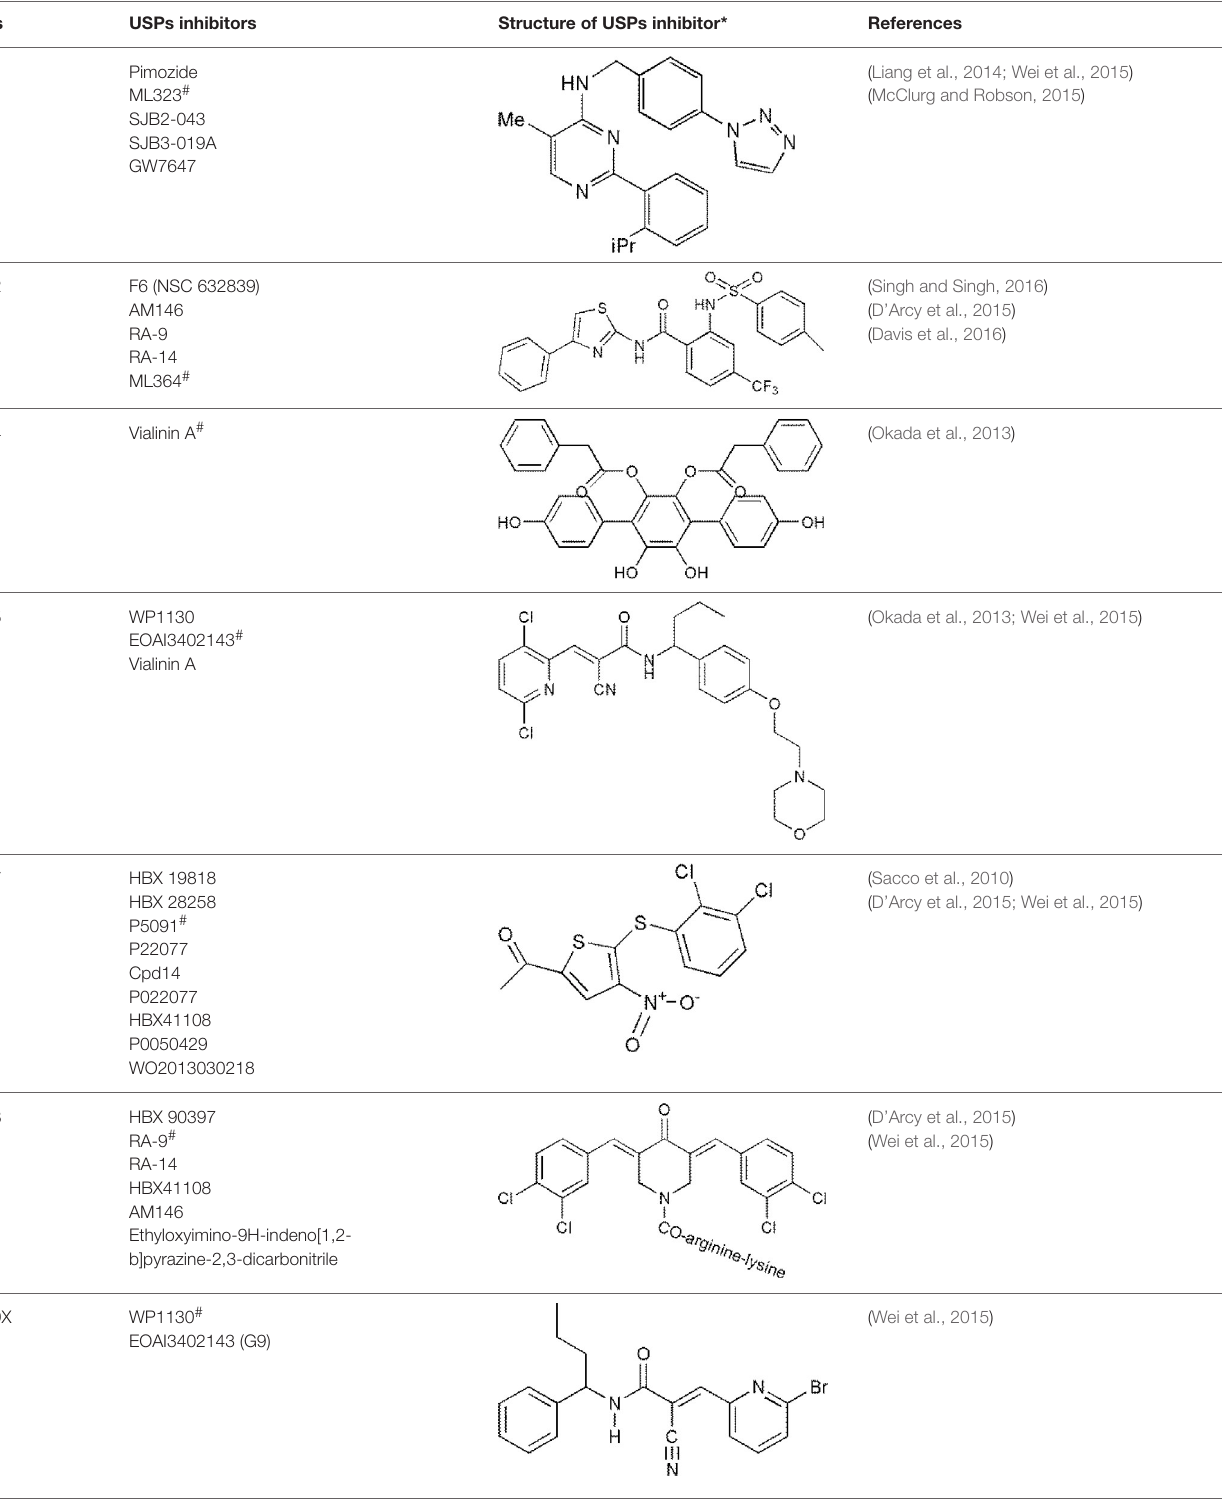
TABLE 1 | Reported inhibitors targeting